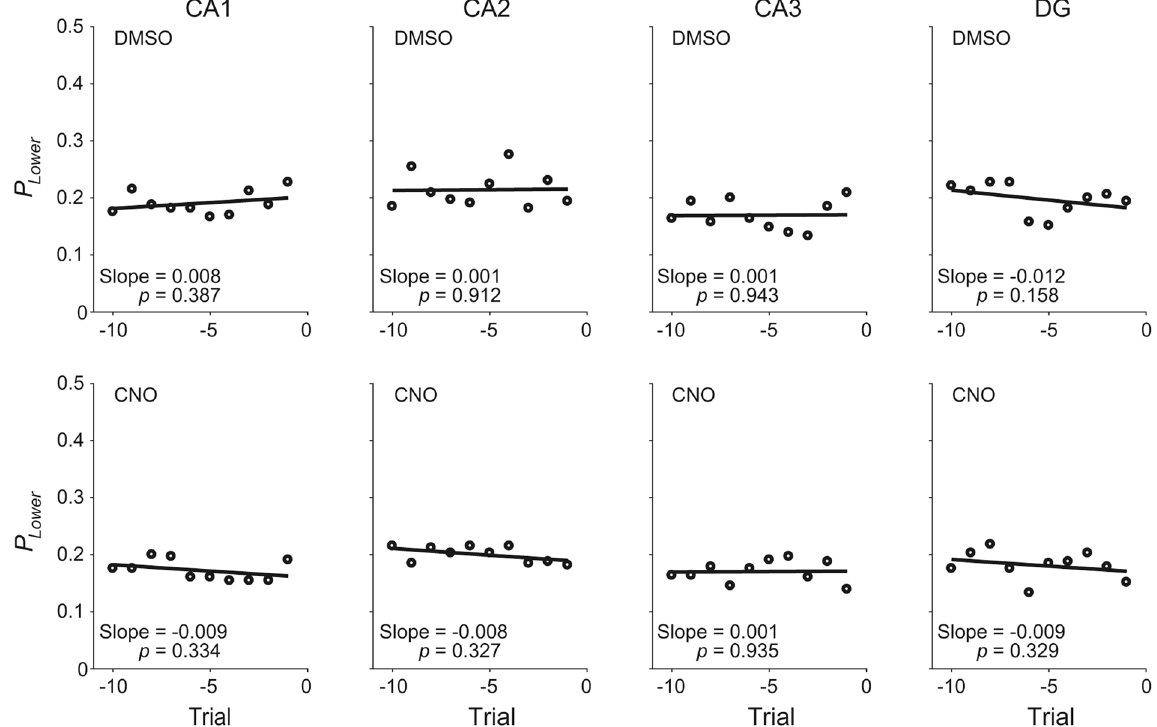
Figure 6. Analysis results related to model-based RL. Open circles indicate the probability of choosing the lower-reward-probability target during 10 trials before block transition, which was computed using all choice data of a given animal group under DMSO or CNO condition, and lines were determined by logistic regression. The slopes of logistic regression were not significantly different from zero as indicated by p